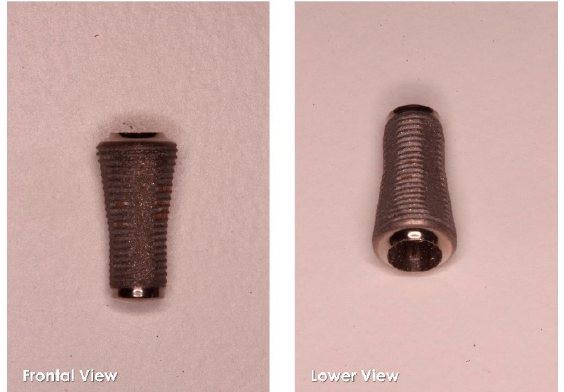
Figure 1. Sinus-Plant (Oralplant Suisse, Mendrisio, Switzerland). Test Implant.